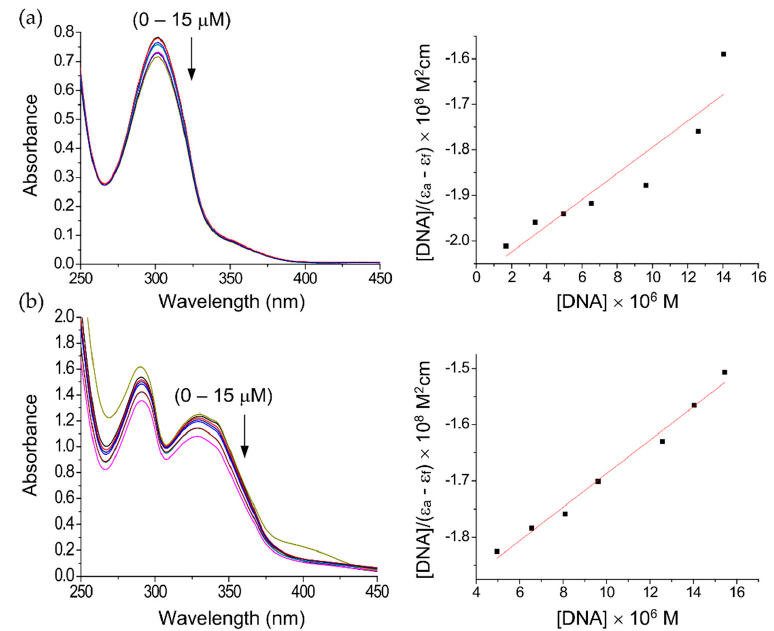
Figure 3. Electronic spectral changes of ( a ) complex ( 1 ) and ( b ) complex ( 2 ) in Tris-HCl buffer (pH = 7.4) with increasing concentrations of DNA; [DNA] = 0–15 µM.